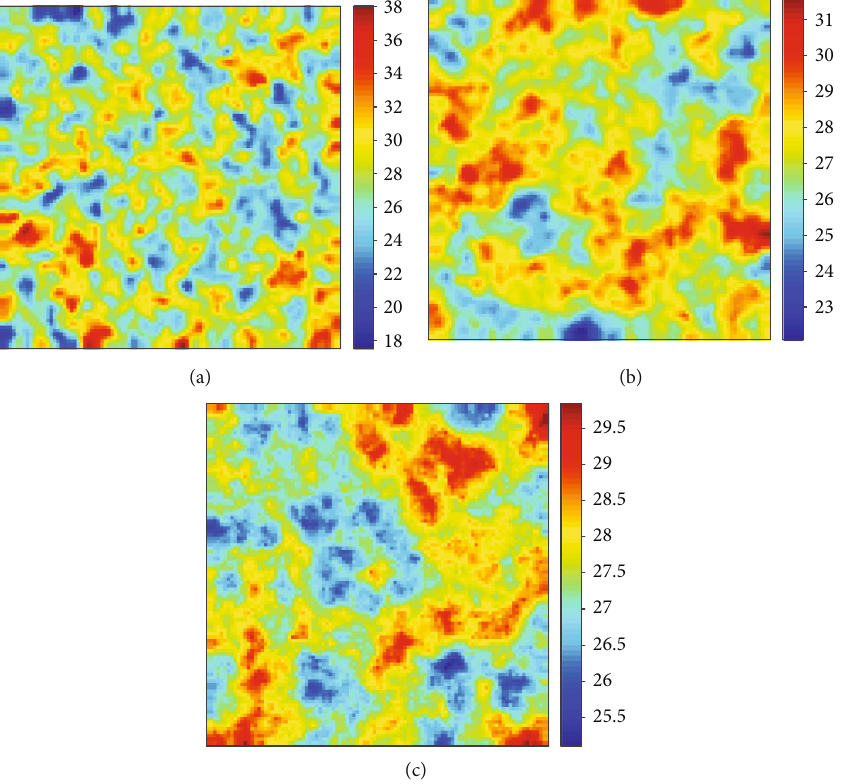
Figure 4: Knowledge temperature distribution contours at t = 100 (a ( u